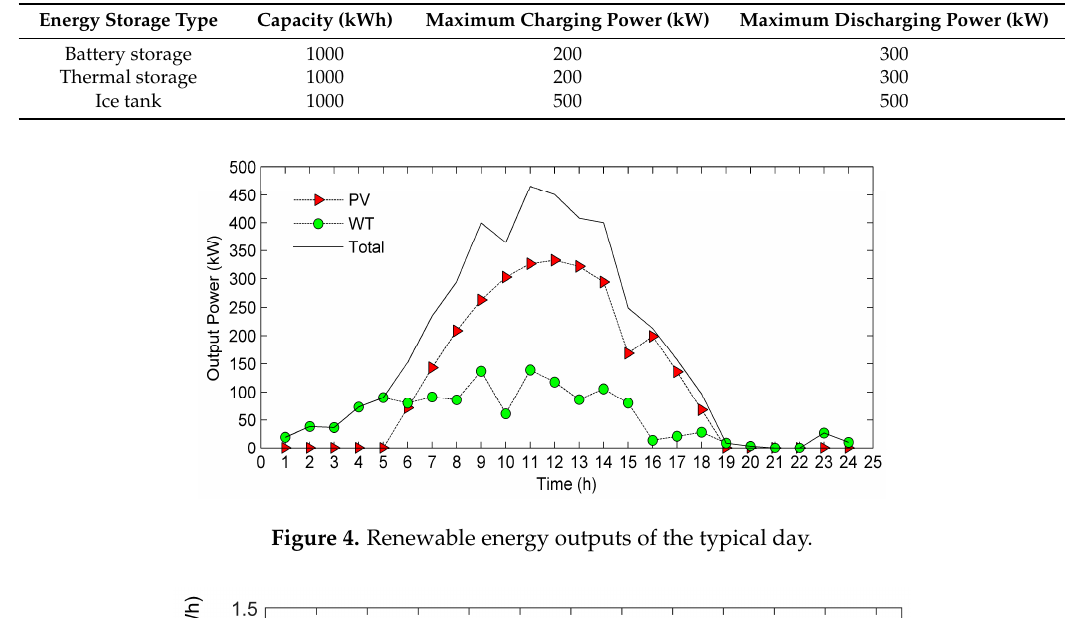
Table 2. Cold, thermal, and electrical energy storage configurations.